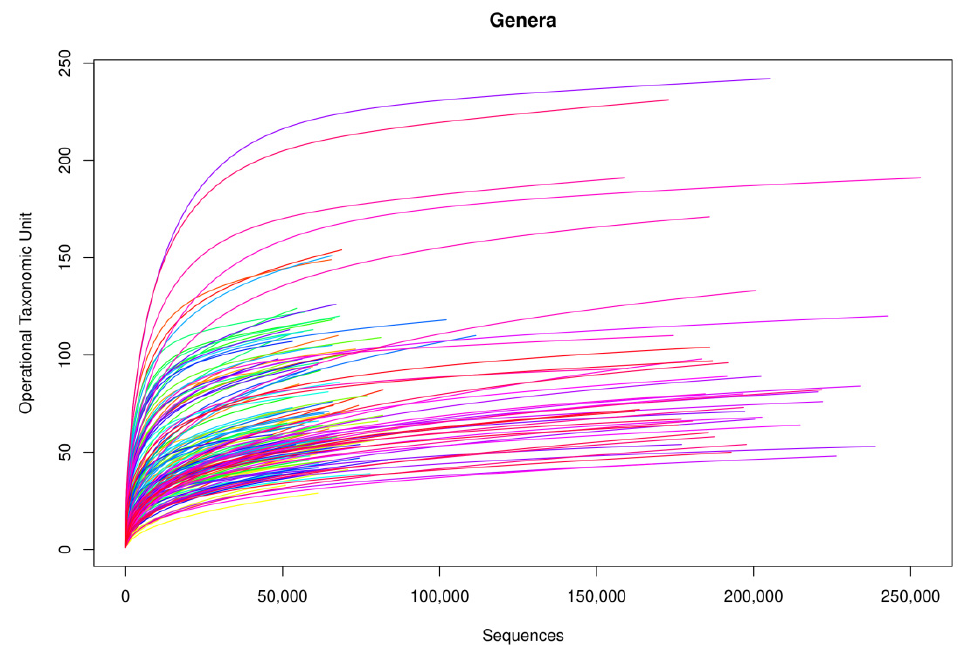
Figure 1. Rarefaction curves of the amplified samples for bacterial detection at a genus level.